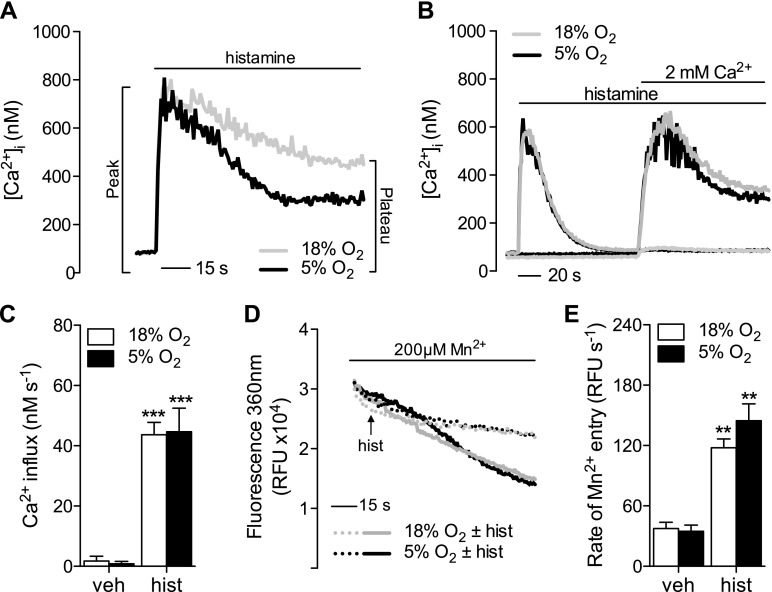
Altered plateau [Ca2+] is not due to reduced Ca2+ influx. HUVECs were cultured under standard (18%) or physiological (5%) O2 levels, and changes in [Ca2+]i were determined using fura-2. A) Representative response to 10 µM histamine (hist) in the presence of 2 mM external Ca2+. B) Ca2+ influx in response to histamine as determined by the Ca2+ add-back assay. Cells were stimulated with histamine or H2O vehicle (veh) in nominally Ca2+-free buffer, followed by readdition of 2 mM Ca2+. A representative trace is shown. C) Mean ± sem (n = 5–8) rate of Ca2+ influx determined by linear regression analysis of the initial rise in [Ca2+]i upon readdition of external Ca2+. Mn2+ (200 µM) influx is shown as a proxy for Ca2+, measured as the rate of decrease in emitted fura-2 fluorescence when excited at 360 nm in the presence of 2 mM external Ca2+. D) Representative trace. The arrow denotes addition of histamine (10 µM). E) Summary of the means ± sem from 3 different donors. RFU, relative fluorescence units. **P < 0.01, ***P < 0.001 vs. control.